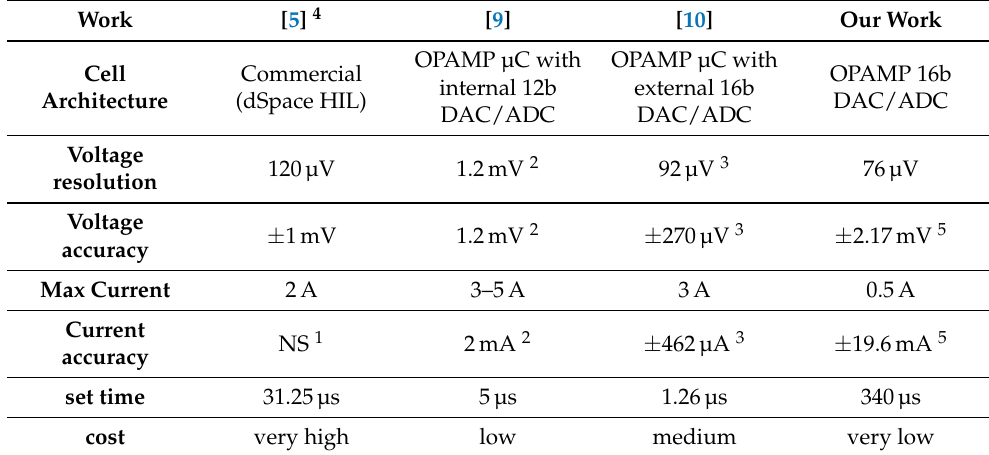
Table 2. Comparison of our cell emulator with the